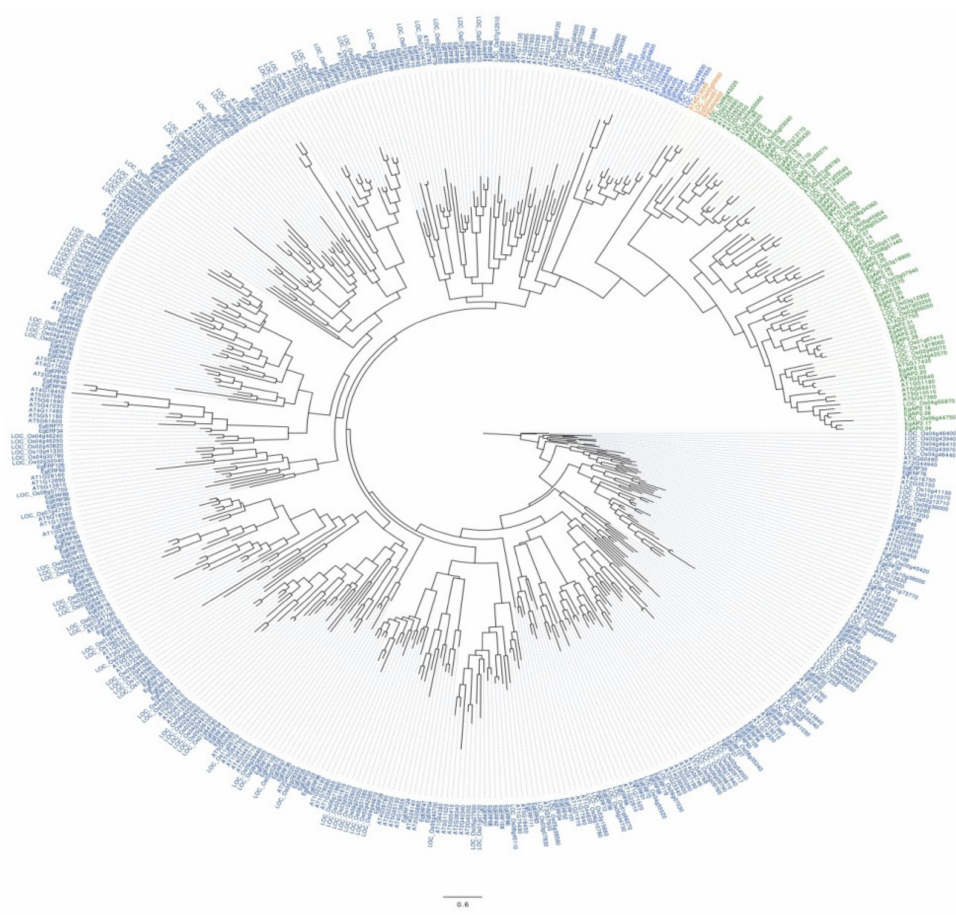
Figure 2. Phylogenetic analysis of AP2/ERF (AP2, ERF, RAV , and Soloist ) family members in oil palm, Arabidopsis, and Oryza sativa . Each of the families from oil palm, Arabidopsis , and rice are grouped and represented in various colors (Navy blue, blue, orange, and